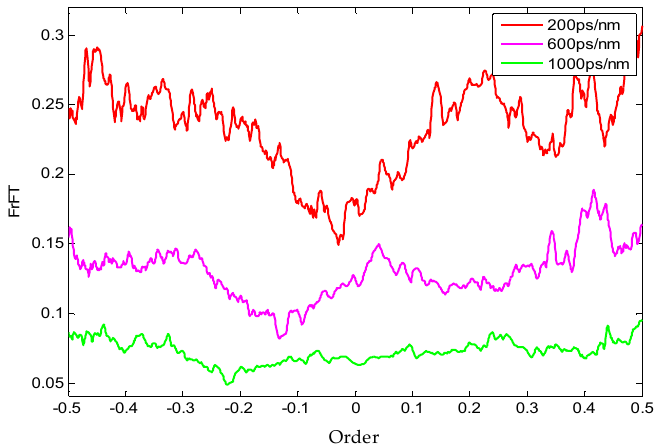
Figure 16. FRFT results of the OOK signal after different dispersion transmissions. For the OOK signal, we estimate the CD within the range of − 1200 ps/nm to 1200 ps/nm set in the experiment and obtain the estimation error value and error rate results within this range, as shown in Figure 17. It can be seen from the figure that for the OOK signal, the estimated CD error value changes with the set real cumulative range. It can be seen from the figure that both fluctuate within a fixed range, and the average value of CD error is 80 ps/nm, the maximum value is 103 ps/nm, and the average value of error rate is only 0.17. It is worth noting that the estimation error is still within the tolerance range of the estimation error mentioned above and will not affect the BER performance of the